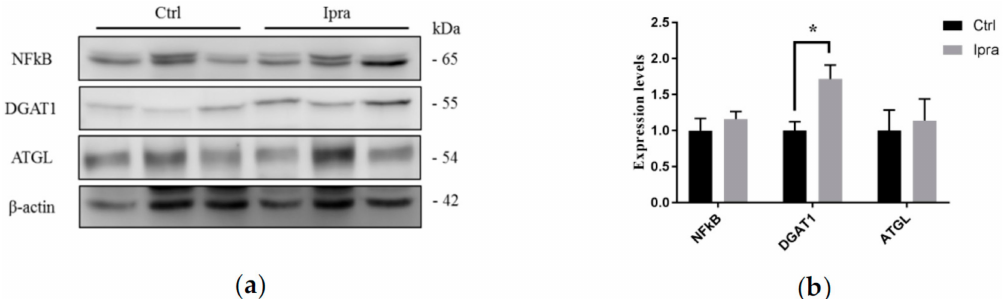
Figure 6. Expressions of lipid-associated protein. ( a ) Western blot analysis for NFkB, DGAT1, and ATGL on kidney tissues from FLS- ob / ob mouse. Beta-actin is used as a loading control. ( b ) Quantification of western blot signal intensities, expressed as relative level to control group. Bars indicate average ± SEM. * p < 0.05; ** p < 0.01 (unpaired t -test). Ctrl, control group; Ipra, ipragliflozin group.